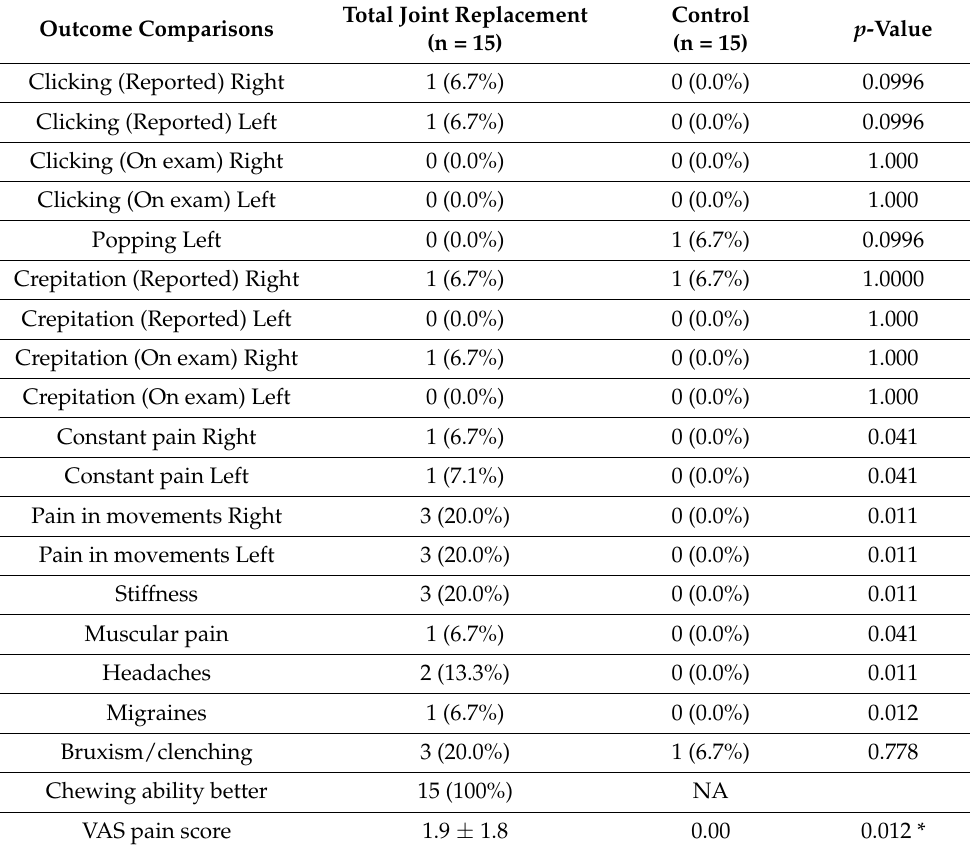
Table 2. Subjective symptoms on the sides of jaw examined and p -values of